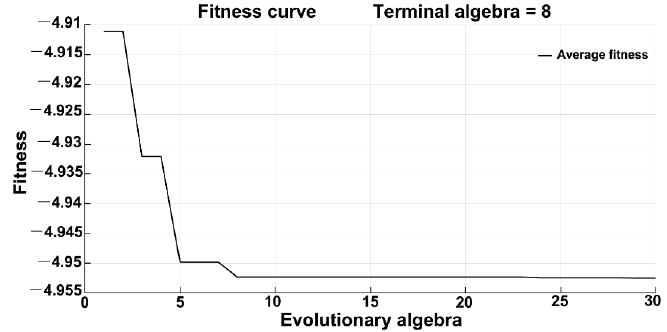
Figure 5. Fitness curve of the PSO algorithm of the monitoring model.